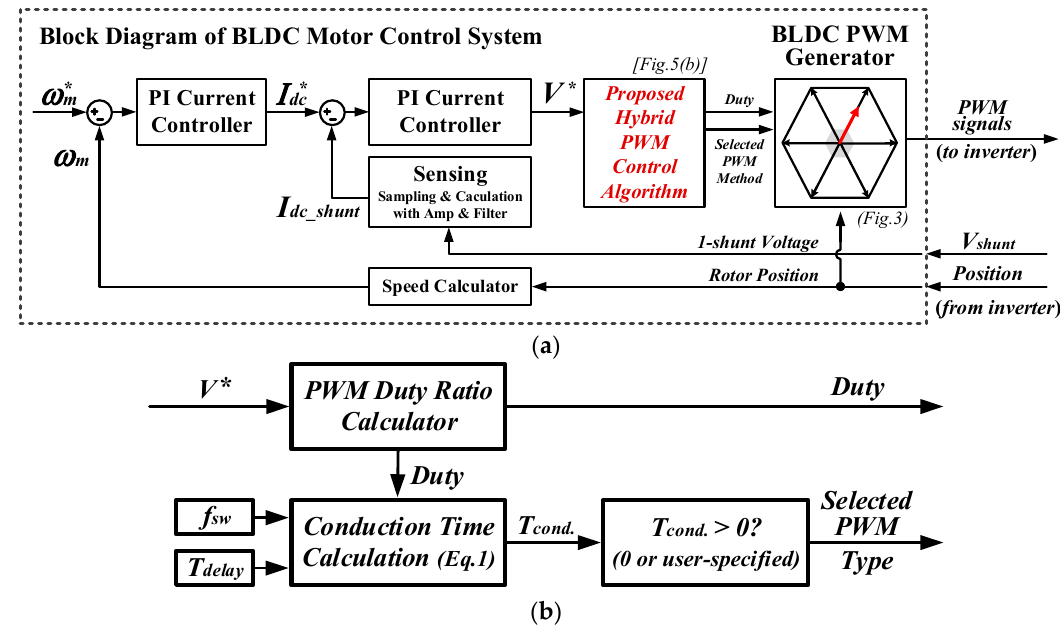
Figure 7. Block diagram of BLDC motor control system with proposed hybrid PWM control algorithm: ( a ) BLDC motor control system; and ( b ) proposed hybrid PWM control